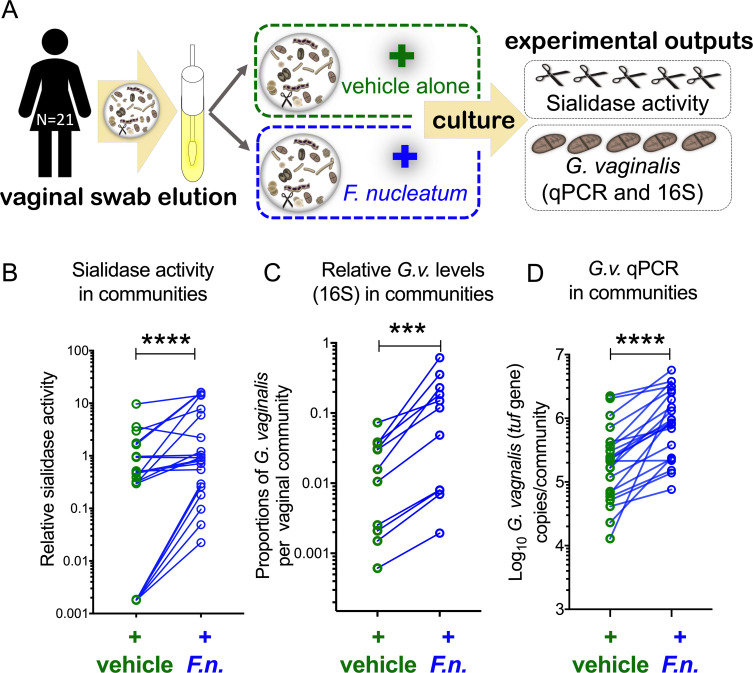
F.n. supports Gardnerella growth and stimulates sialidase activity within human vaginal communities.(A–D) Human vaginal communities from 21 individual women were used. (A) Microbial communities were eluted from vaginal swabs under anaerobic conditions in nutrient-rich media. Communities with potential sialidase producers (sialidases are represented as scissors) were cultivated anaerobically in supplemented Columbia media in the presence or absence of added F.n. (B) Sialidase activity was measured following anaerobic culture. Negative values were set to 0.0018 (lowest positive value) to depict them on the log scale. Graphs show data combined from 2 independent experiments. (C) Relative abundance of G.v. in cultured human vaginal communities. Sequencing of the gene encoding the V4 region of 16S rRNA was used to estimate proportions of G.v. in the microbial communities. (D) Quantitation of G.v. in cultured human vaginal communities by tuf qPCR. In each case, statistical comparison between the 2 groups was performed using Wilcoxon matched-pairs signed rank test. The underlying numerical data for this figure can be found in S1 Data. On all graphs, ***P < 0.001, ****P < 0.0001. F.n., F. nucleatum; G.v., G. vaginalis; qPCR, quantitative PCR; tuf, Translation elongation factor Tu.